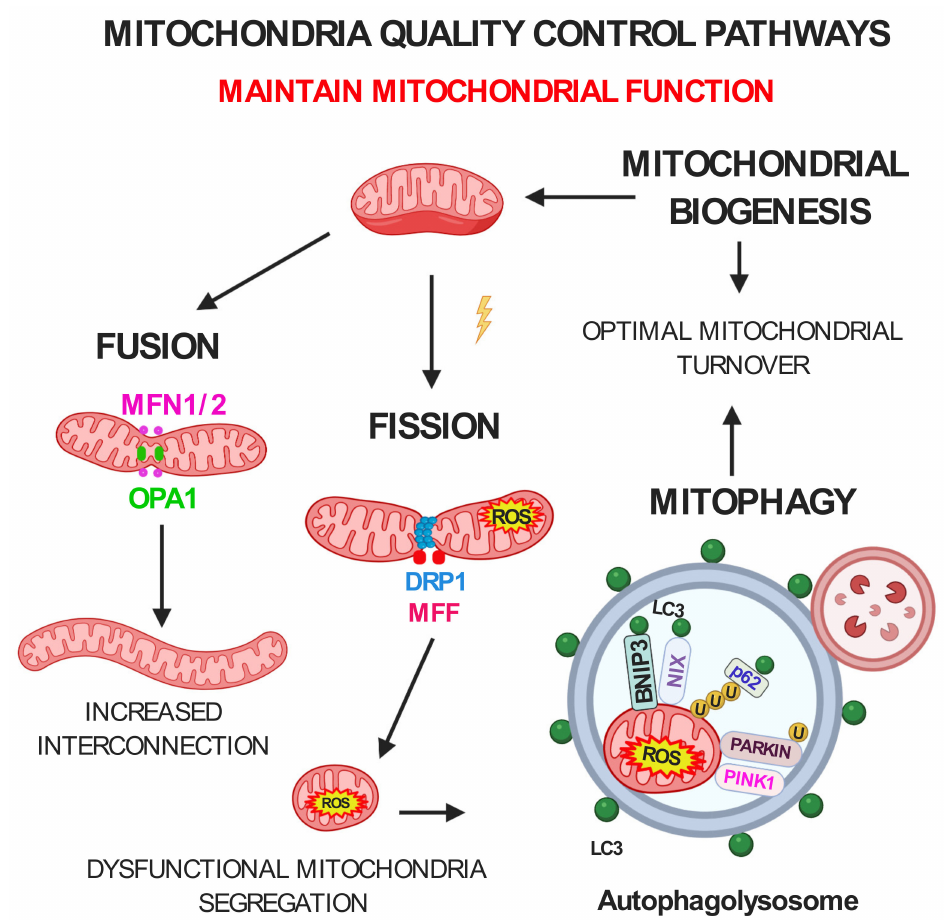
Figure 1. Mitochondria quality control pathways maintain mitochondrial function. Mitofusin 1 and 2 (MFN1/2) and optic atrophy protein 1 (OPA1) mediate mitochondrial fusion to produce an interconnected healthy mitochondrial network. Mitochondrial fission depends on dynamin-related protein 1 (DRP1) and mitochondrial fission factor (MFF) proteins. Fragmented dysfunctional mitochondria are removed by mitophagy. Bcl2/adenovirus E1B 19 kDa protein-interacting protein 3 (BNIP3) and NIP3-like-proteinX (NIX) are mitophagy receptors that bind to microtubule-associated protein 1 light chain 3 (LC3) to tether mitochondria to the autophagosome. PTEN-induced kinase 1 (PINK1) accumulates on depolarized mitochondria surface, where it phosphorylates ubiquitinated outer mitochondrial membrane (OMM) proteins and Parkin. Parkin will further promote the ubiquitination of the OMM proteins. The p62/SQSTM1 adaptor can recognize the ubiquitinated proteins to initiate mitophagy. U: ubiquitin. Figure was created with